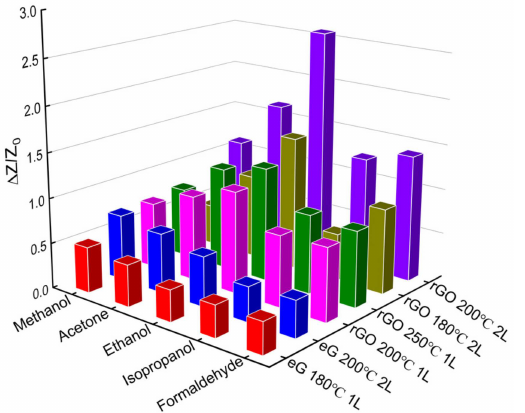
Figure 7. Comparison of responses from each sensor in the array toward the target VOCs at 80 ppm. The eG sensors have less intense response than the rGO sensor, rich in surface defects. Such defects enhances the rGO sensor gas molecule capturing. For single sensors, rGO re- sponses more strongly toward ethanol and acetone than other VOCs, whereas eG responses the best toward methanol and acetone. Most importantly, both rGO and eG shows unique response selectivity to all the measured VOCs, and each VOC elicited a unique response pattern. Using different thermal treatments for graphene-based materials is decisive for the selectivity of the sensor array and enhances the pattern recognition